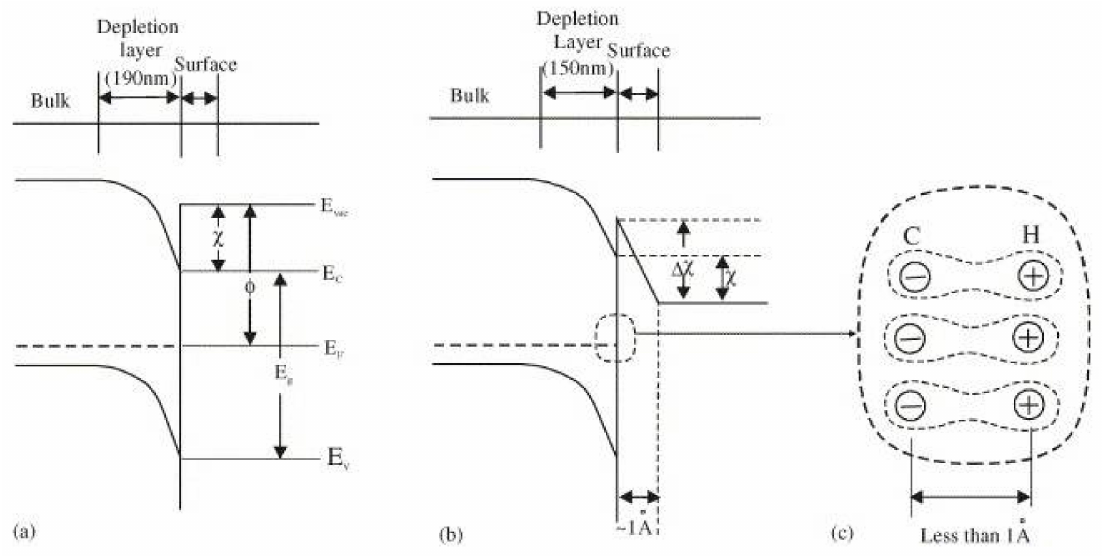
Figure 5. ( a ) Schematic of the energy band diagram for a clean diamond surface with a positive electron affinity. ( b ) Schematic of the energy band diagram of a hydrogenated diamond surface with negative electron affinity. ( c ) Possible atomic arrangement of dipole layer on the hydrogenated diamond surface. The mentioned “surfaces” refer to the single crystalline type IIb diamond. Image reproduced with permission from [67], Copyright Elsevier,